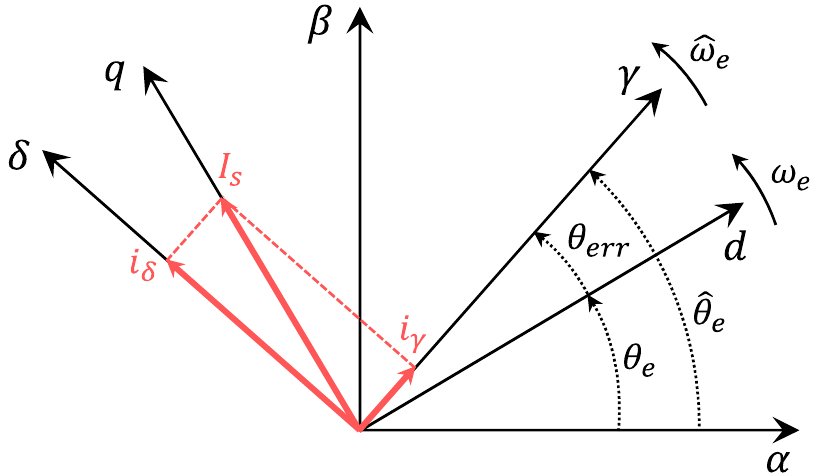
Figure 10. Vector diagram of PMSM defining stationary and rotating reference frames.